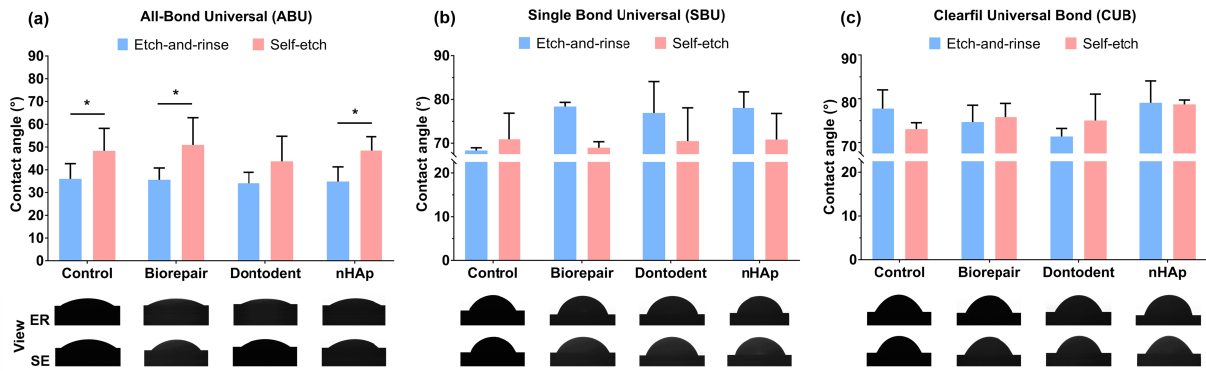
Figure 6. Contact angle values and anterior view of universal adhesives on dentin substrates after desensitization. ( a ) All- Bond Universal. ( b ) Single Bond Universal. ( c ) Clearfil Universal Bond. * denotes a significant difference between the etch-and-rinse mode and self-etch mode ( p < 0.05).